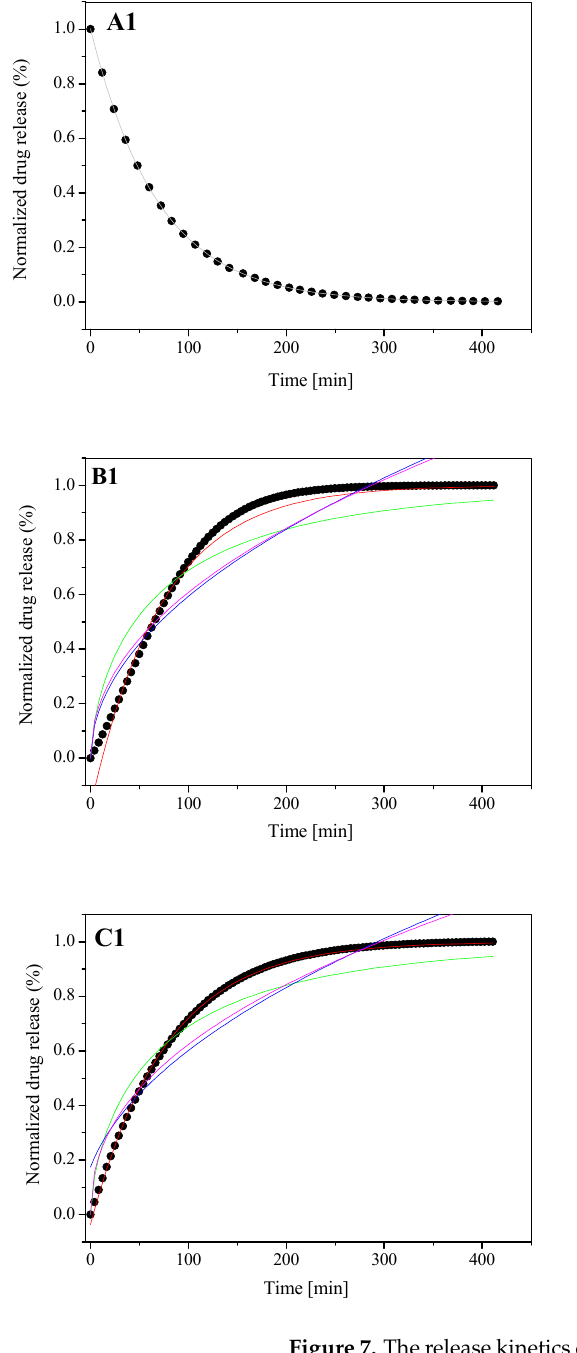
Figure 7. The release kinetics of 5-MBT from the L DPPC/5-MBT liposomes ( A1 – C1 ) and their complexes with HSA [L DPPC/5-MBT ]:HSA ( A2 – C2 ). ( A ) pH 4.47, ( B ) pH 5.59, ( C ) pH 6.10. Colored lines corre- sponding to the fits of the mathematical models. Black dot lines corresponding to the experimental data. ( - ) Korsmeyer–Peppas model; ( - ) first-order model; ( - ) Bhaskas model; ( - ) Higuchi model; ( - ) Ritger–Peppas